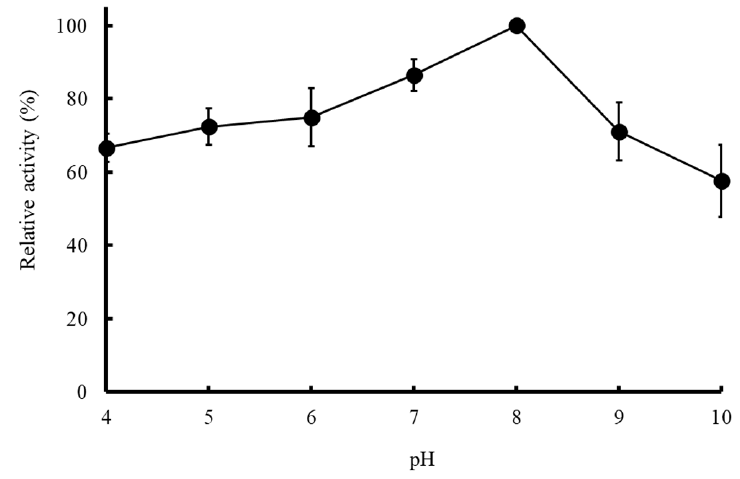
Figure 6. The pH-dependent activities of the purified MD2-SBro. The highest activity at pH 8.0 (3.56 × 10 − 3 U/mg) was adjusted as 100%.